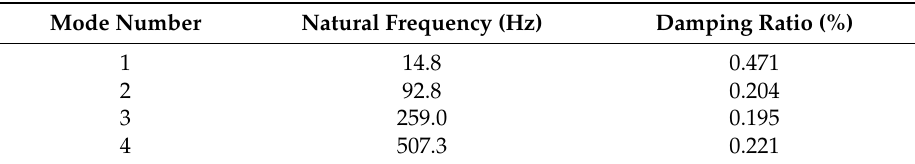
Figure 5. Stabilisation diagram. Table 2. The estimated natural frequencies and damping ratios of the pipe.